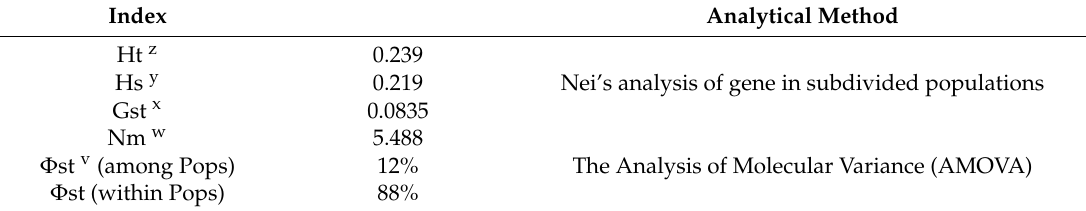
Figure 2. Phylogenetic trees of 33 plum varieties constructed based on ISSR data: An unrooted tree established using the NJ method ( A ) and a tree constructed using the NNet method calculated from the uncorrected p distances ( B ). Table 4. Analysis of genetic structure in subdivided populations.